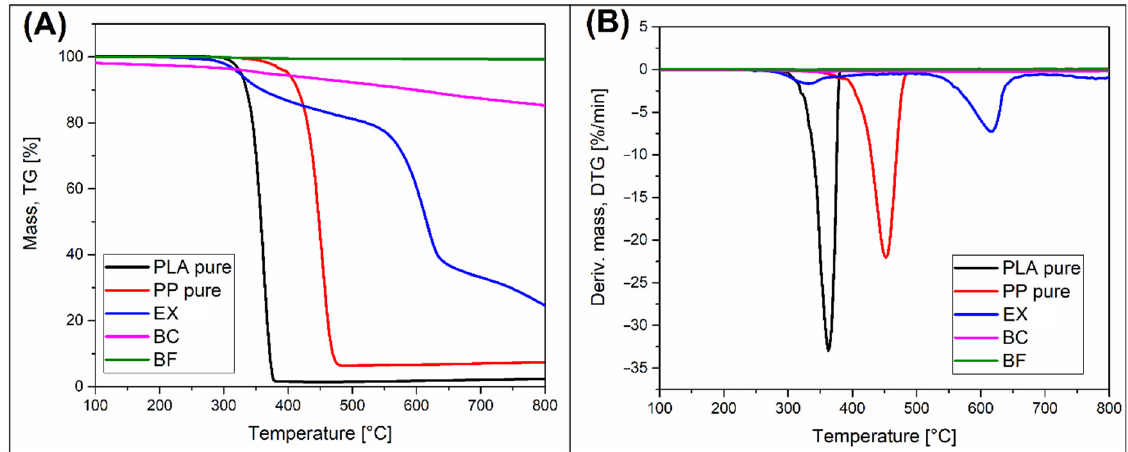
Figure 3. The thermogravimetric (TGA) analysis of pure polymers and filers: ( A ) TG and ( B ) DTG plots.